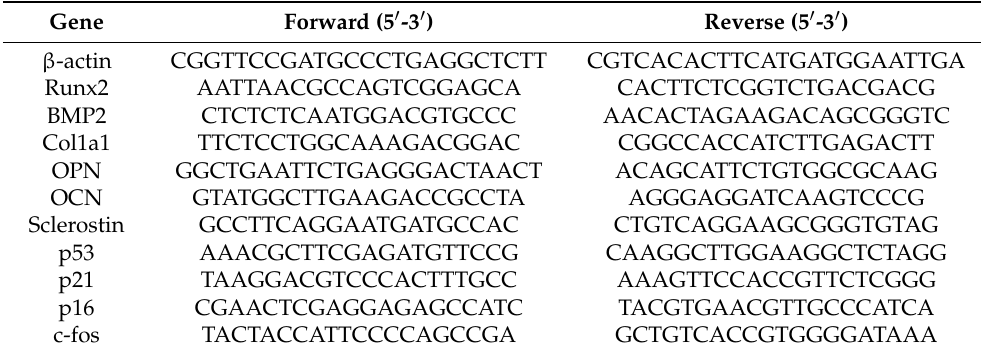
Table 1. Design of